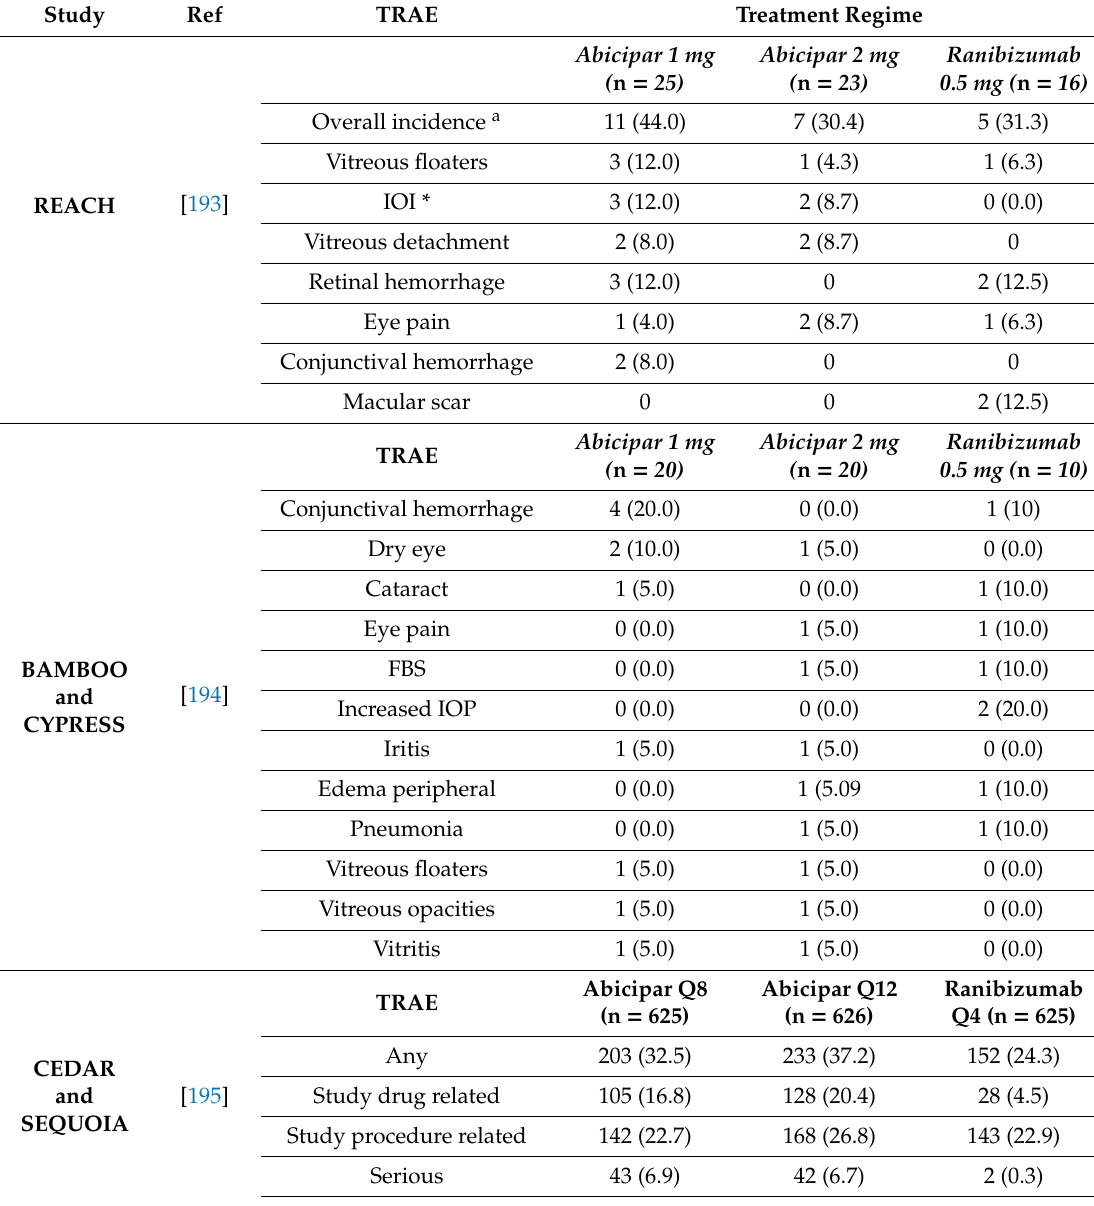
Table 10. Ocular adverse events reported in di ff erent studies evaluating designed ankyrin repeat proteins